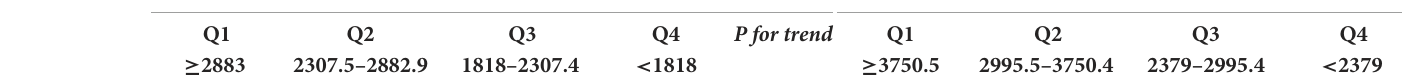
TABLE 3.1 Associations of FEV1 and FVC with coronary heart disease mortality in U.S. adults aged at least 20 years among different